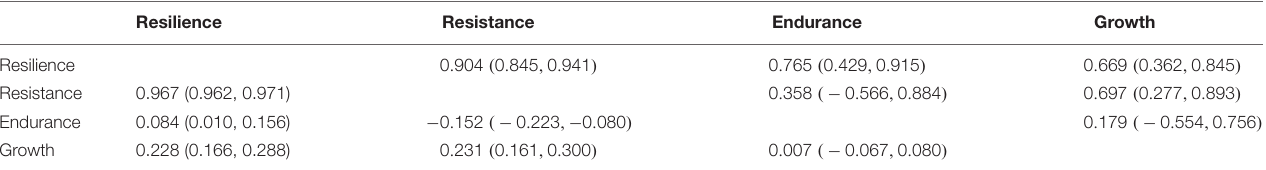
TABLE 4 | Genetic (above diagonal) and phenotypic (below diagonal) correlations between disease resistance traits and between disease resistance traits and growth derived from linear model